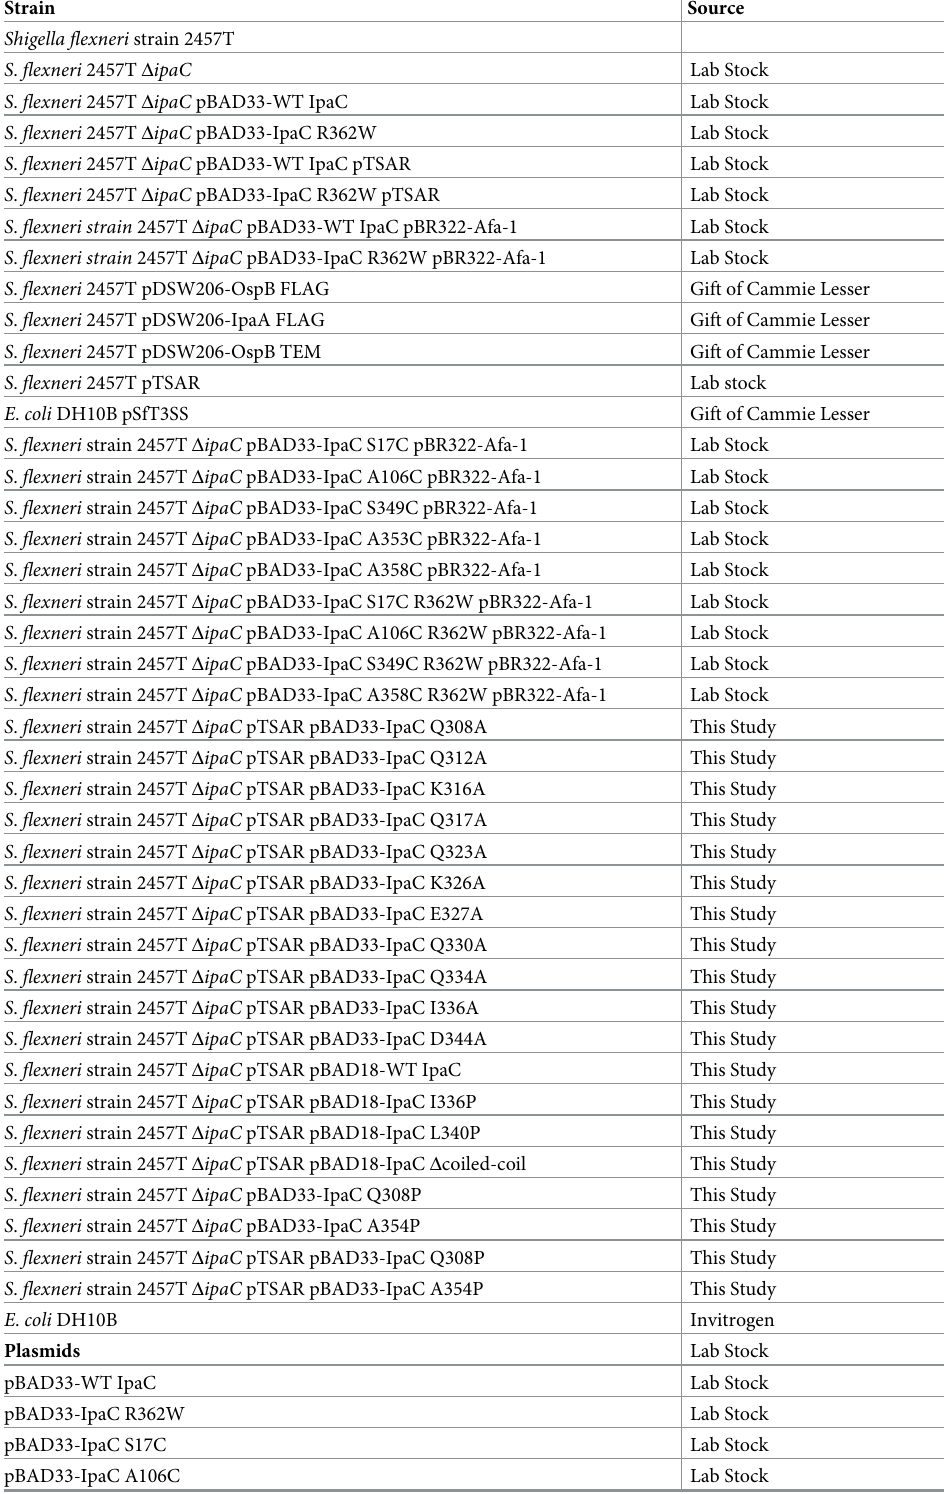
Table 1. Strains and